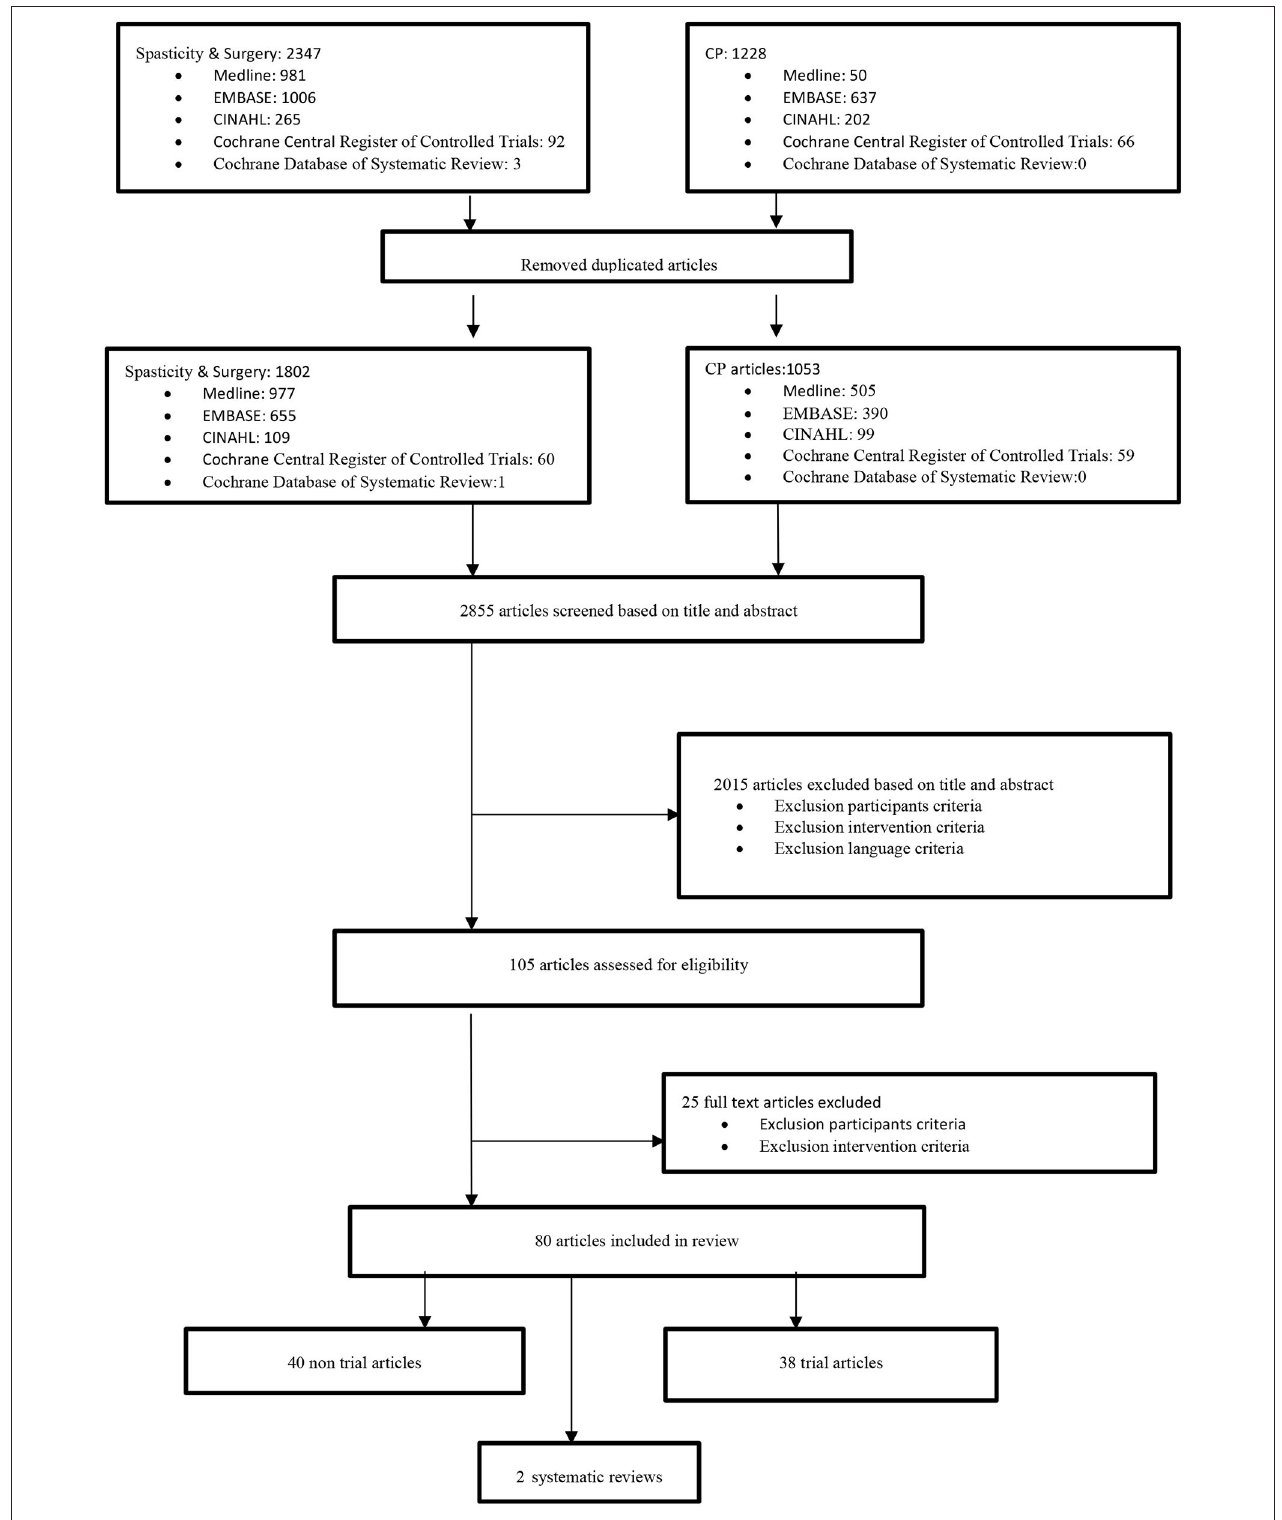
FIGURE 1 | Data collection